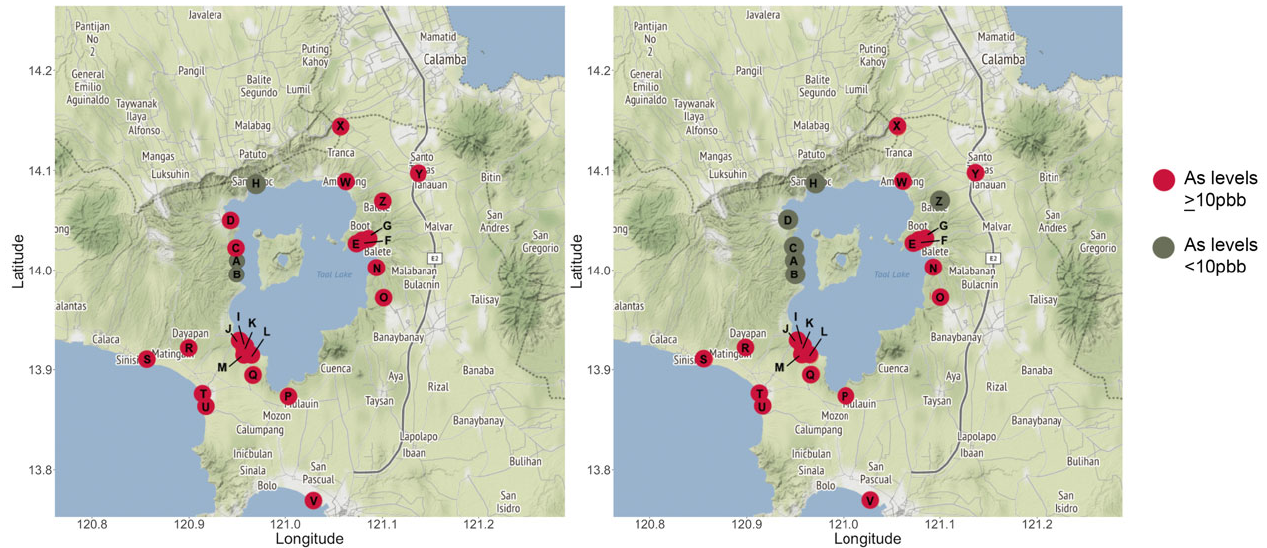
Figure 4. Geocoded map of study wells with persistently high As levels in 2020 and 2021 .